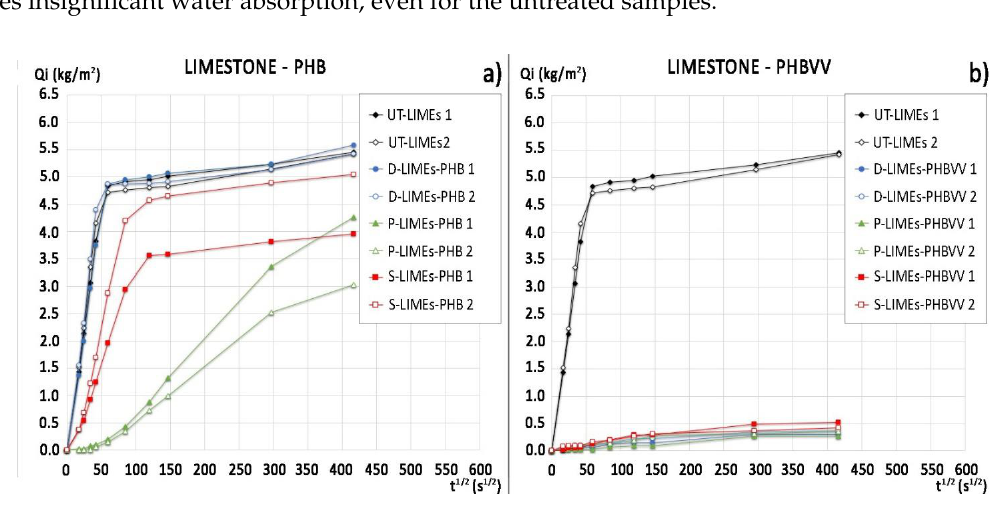
Figure 5. Water absorption curves of limestone samples treated with: ( a ) PHB-based formulation by dip coating, poultice and spray and of untreated samples (duplicate samples for each condition); ( b ) PHBVV-based formulation by dip coating, poultice and spray and of untreated samples (duplicate samples for each condition). Table 4. Determination of the mean ratio of protection (Rp, %) for treated samples of sandstone after 1 h and after 48 h of capillary absorption test.